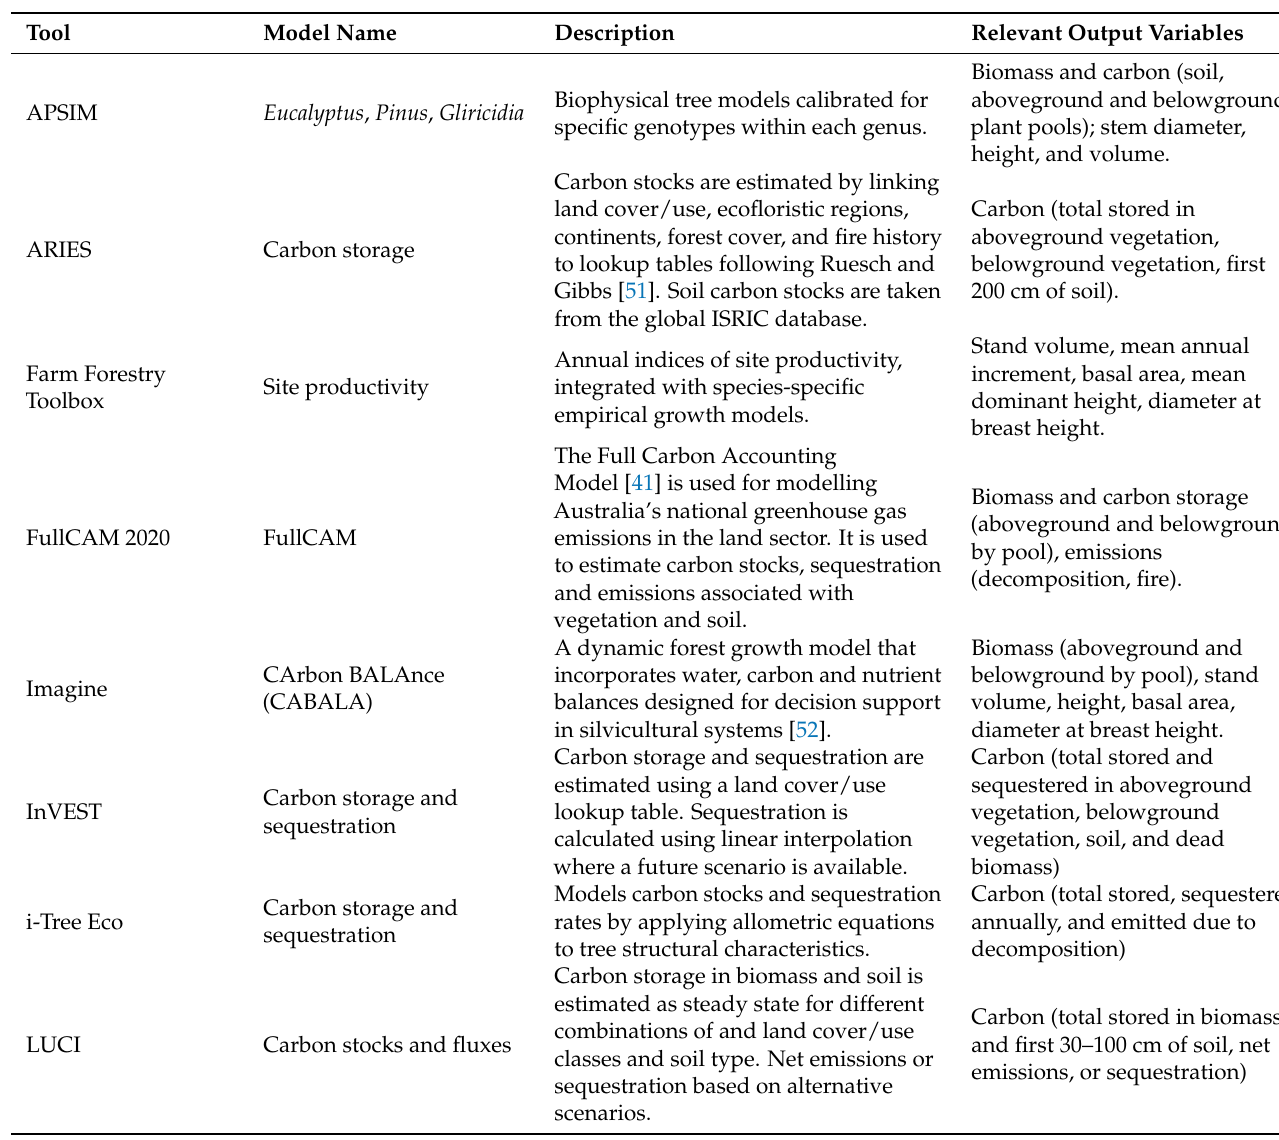
Table 2. Summary of the shortlisted tools and associated models that quantify timber production and carbon